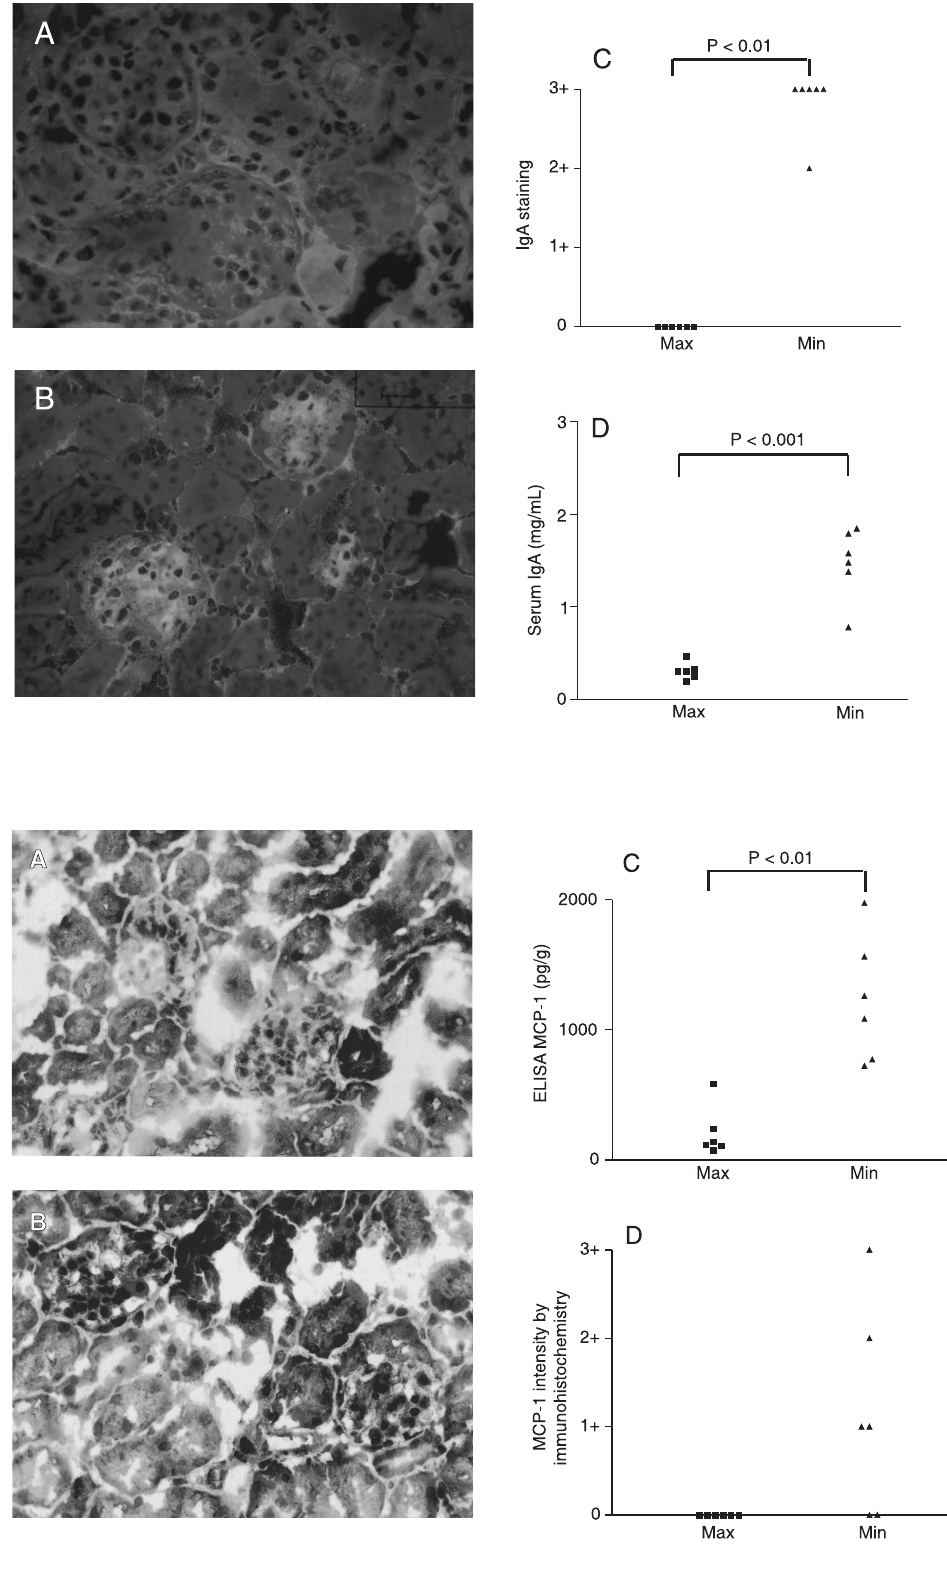
Figure 2. A , Negative staining for IgA by immunofluorescence in maximal acute inflammatory response (AIRmax) mice (360X). B , Positive staining for IgA by immunofluorescence in minimal AIR (AIRmin) mice (360X). C , Glomerular deposition of IgA in AIRmax and AIRmin mice with bile duct ligation: IgA deposition was increased in AIRmin. D , IgA production in AIRmax and AIRmin mice with bile duct liga- tion: serum IgA levels were higher in AIRmin.